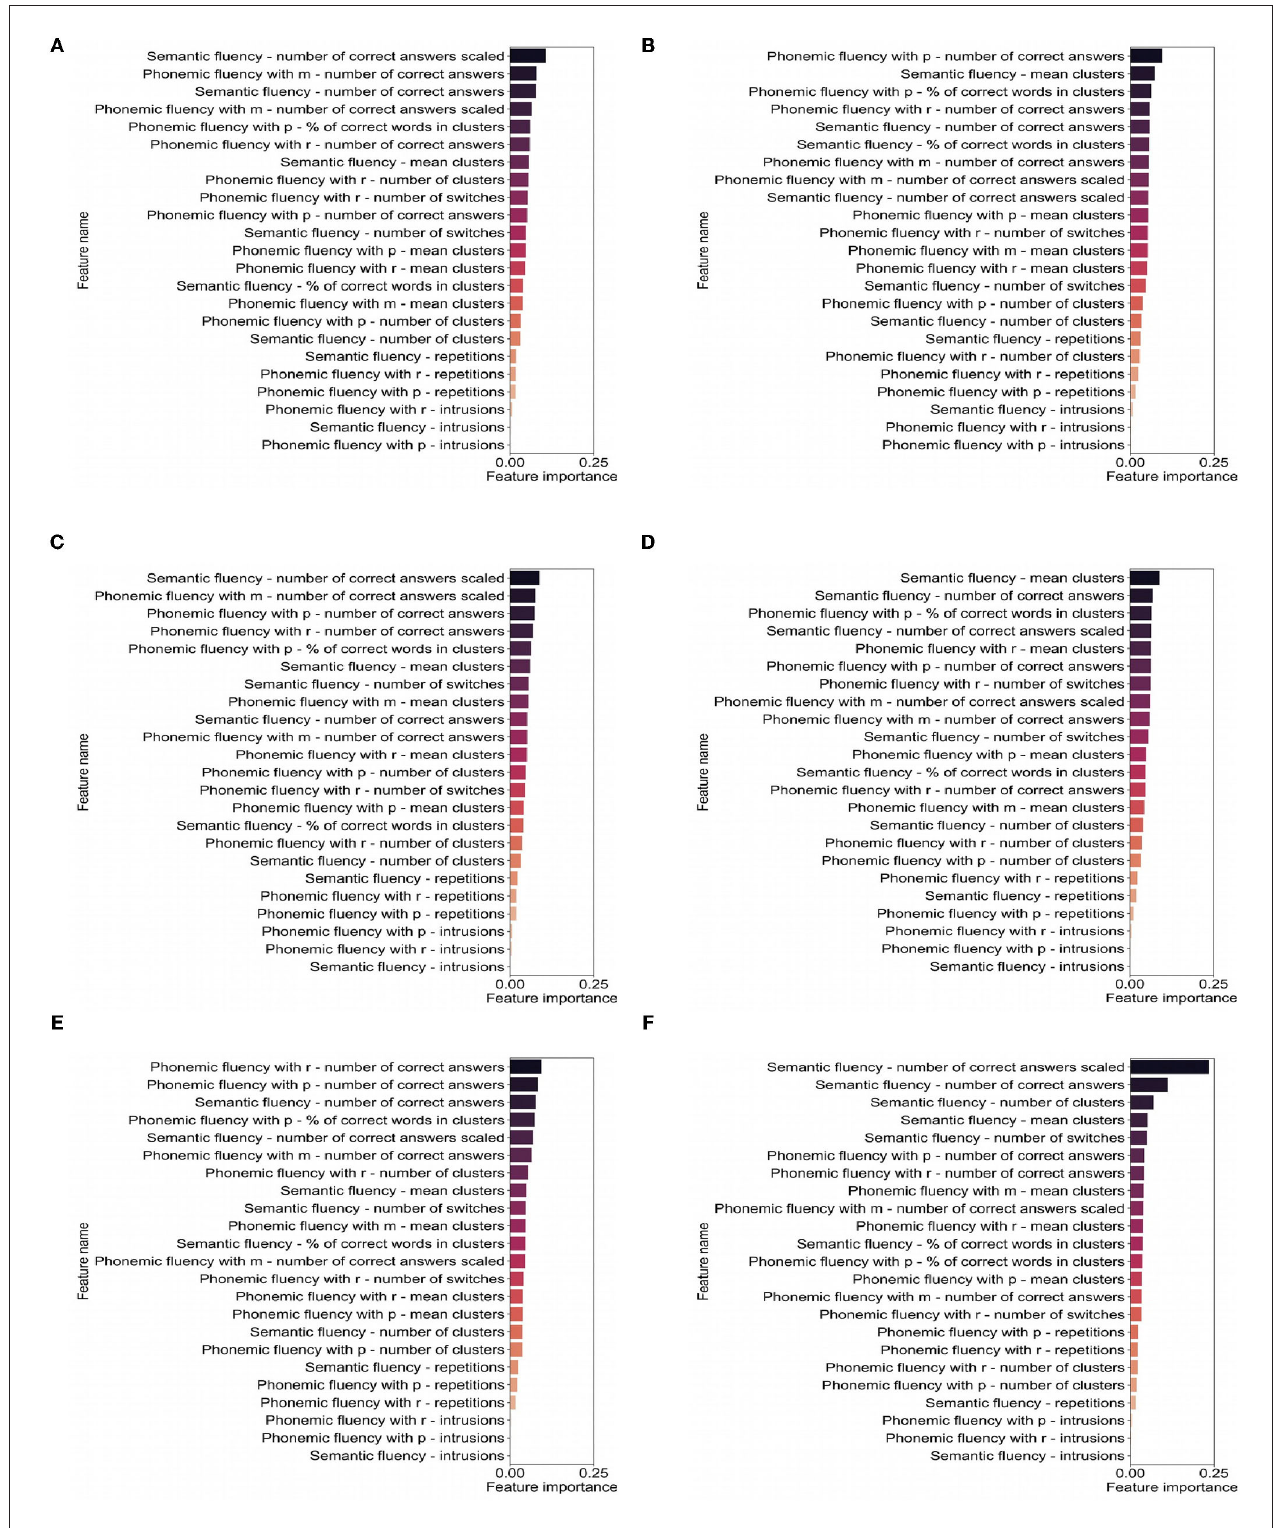
FIGURE 3 | Features importances obtained with each Random Forest model for each classification task: (A) cognitive impairment, (B) attention and executive functioning, (C) information processing speed, (D) memory, (E) visuospatial function, and (F) language.